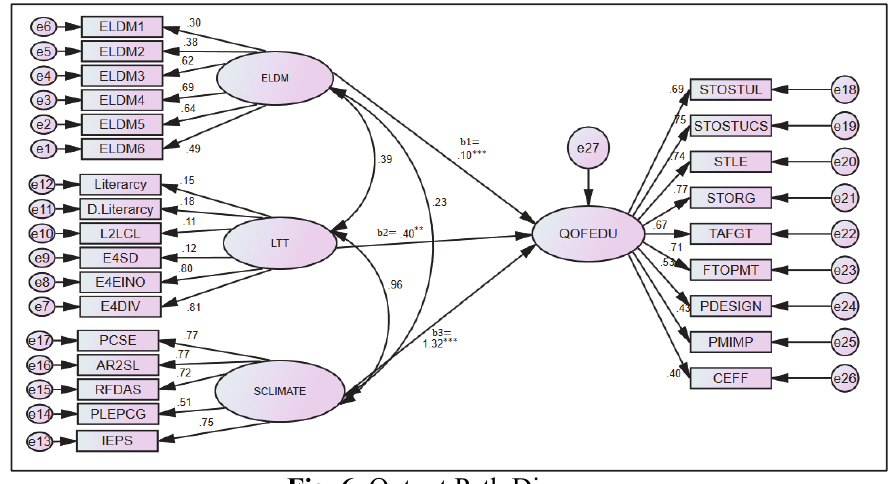
Fig. 6. Output Path Diagram Estimate Estimate